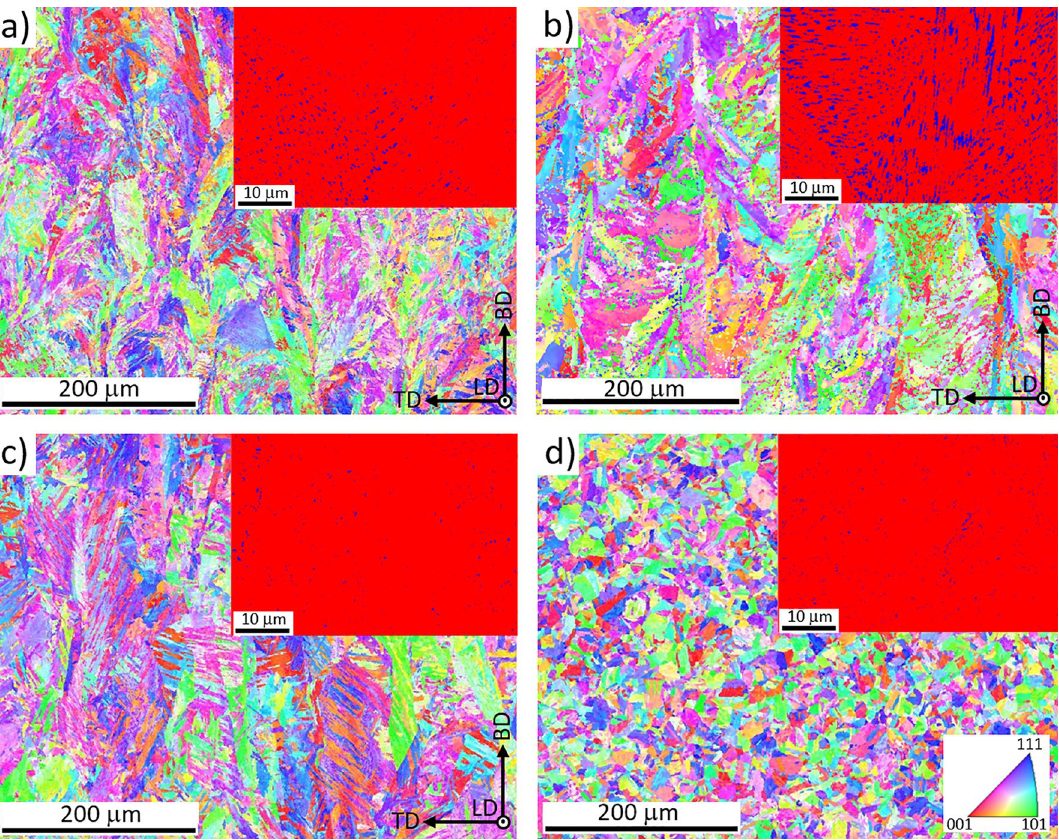
Figure 4. EBSD IPF maps in the BD direction with insets of EBSD phase analysis obtained at higher magnification of: ( a ) AM, ( b ) AM + DAT, ( c ) AM + SAT and ( d ) CM + SAT samples. LD, TD and BD stand for longitudinal, transverse and building direction,